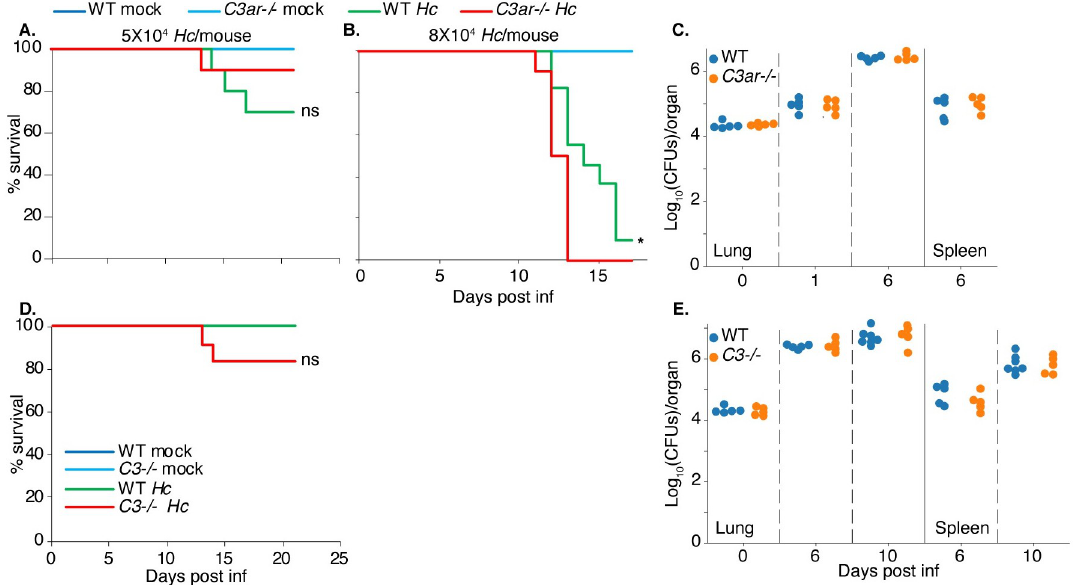
Fig 7. C3 and C3aR-deficiency do not dramatically alter mouse susceptibility to Hc infection. A-B C3ar-/- mice (n � 10) and age- matched WT C57BL/6 mice (n � 10) were infected intranasally with varying doses of Hc yeast to initiate either a sub-lethal (A) or lethal (B) infection. D. C3-/- mice and age-matched WT mice were infected intranasally with a sub-lethal dose of Hc yeast. Susceptibility is illustrated by a Kaplan-Meier survival curve. ns = not significant, � p < 0.05 by logrank test. C,E. The indicated mice were infected with a sub-lethal dose of Hc . The fungal burden in lung and spleen homogenates was determined by enumeration of colony forming units (CFUs) at the indicated time points (n � 5). X-axis label for C is the same as that indicated for E.